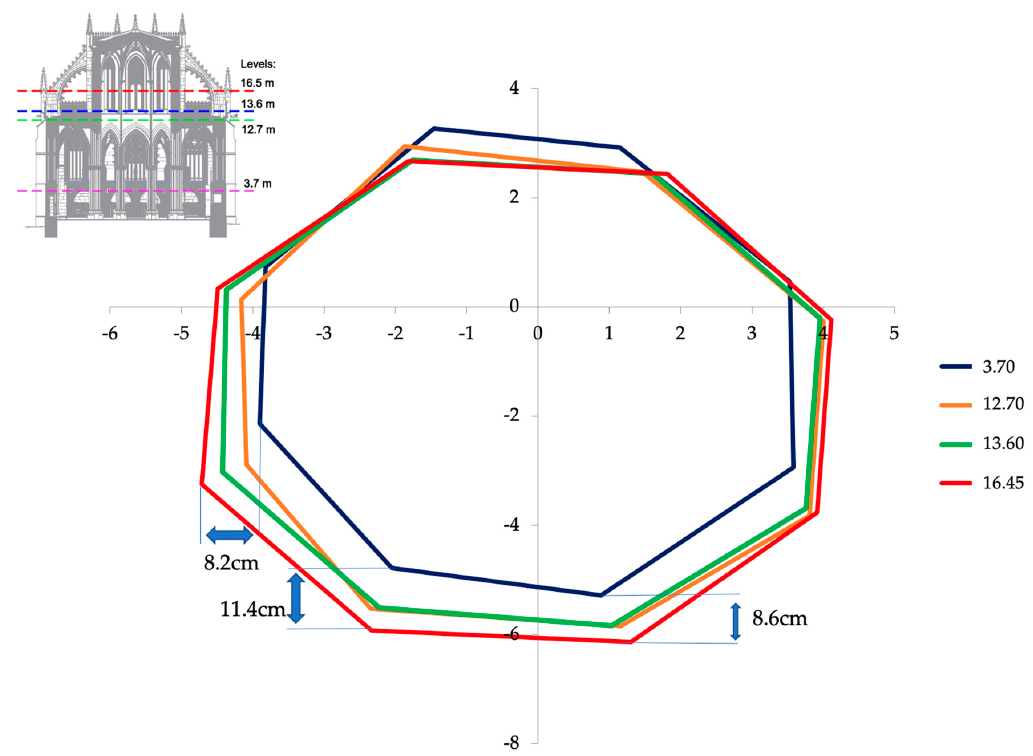
Figure 12. Horizontal displacement at four different levels (3.7 m to 16.45 m) of the star vaulted octagon of the Founder’s Chapel.